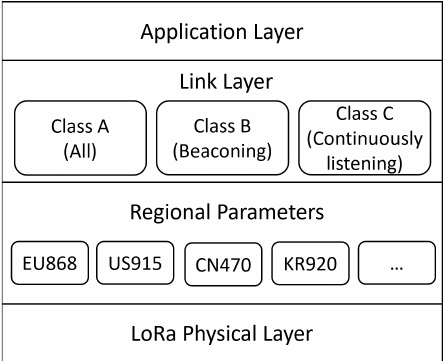
Figure 1. The LoRaWAN network architecture.